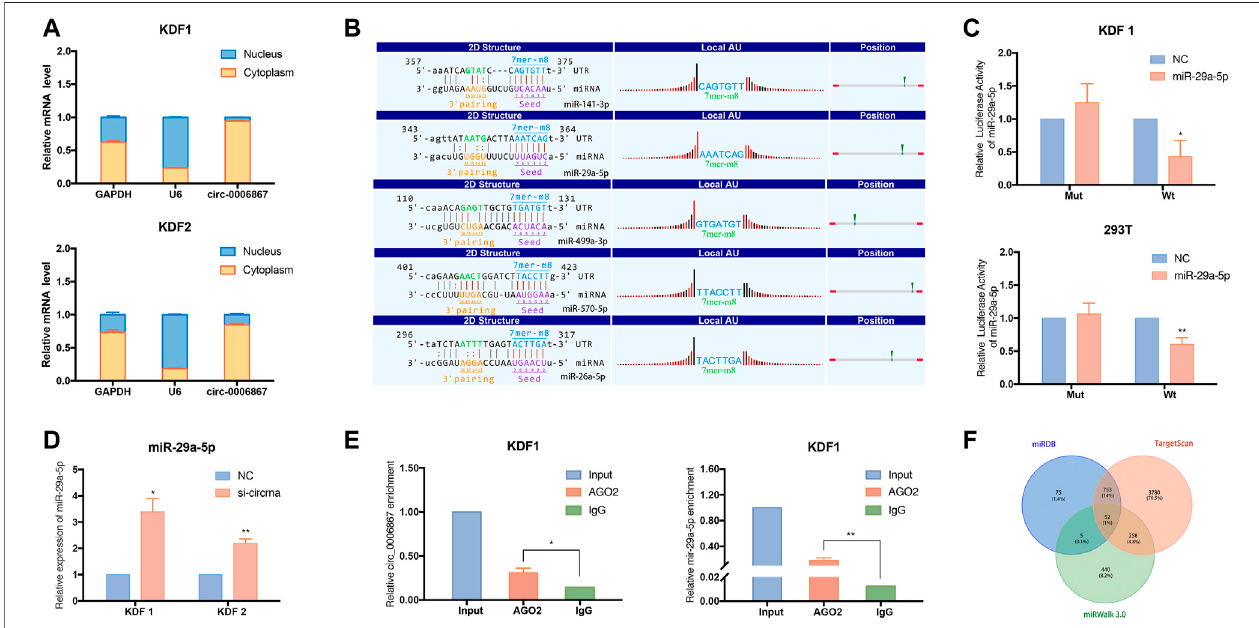
FIGURE 8 | Exploration of the potential regulatory mechanism of hsa_circ_0006867 in keloids. (A) Nuclear and cytoplasmic fractionation assays veri fi ed the localization of hsa_circ_0006867 in KDF1 and KDF2 cells. (B) The fi ve highest ranking target miRNAs of hsa_circ_0006867 and annotation of their circRNA/miRNA interactions. (C) The dual-luciferase reporter assay was performed using 293T and KDF1 cells after cotransfection. (D) The expression of miR-29a-5p was signi fi cantly upregulated after silencing hsa_circ_0006867. (E) The RIP assay showed that hsa_circ_0006867 and miR-29a-5p were enriched in the presence of AGO2 antibody. (F) The Venn plot showed the overlap of the predicted mRNA target of miR-29a-5p based on the datasets from miRDB, TargetScan, and miRWalk